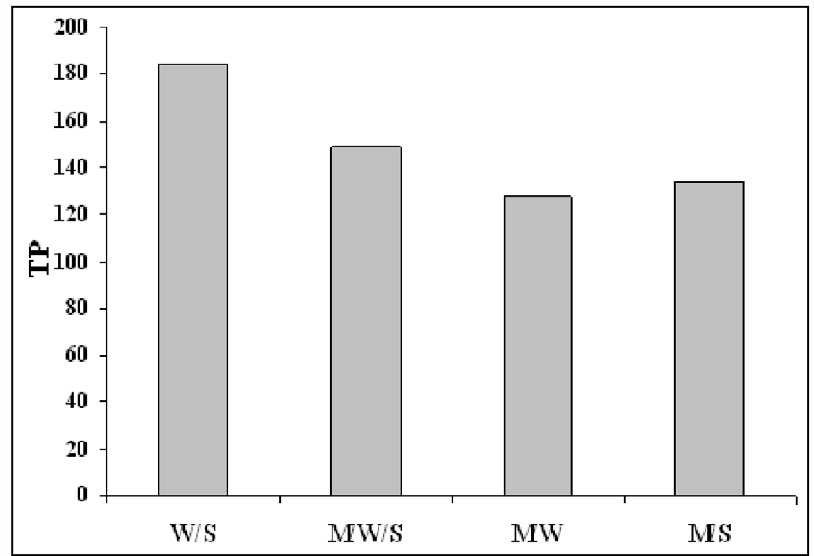
Figure 1. Selection of optimum extracting solution of polyphenols.